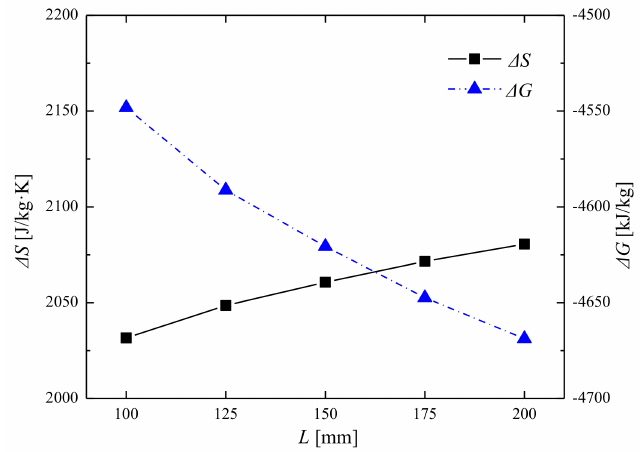
Figure 18. Variations in ∆ S and ∆ G with different axial